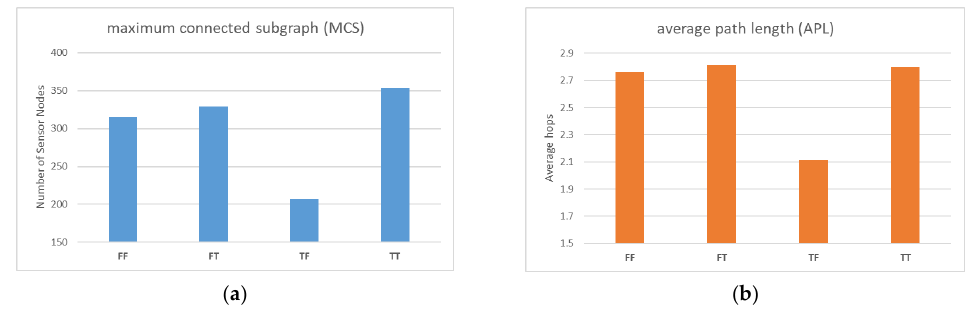
Figure 6. ( a ) Comparison of MCS with different parameter settings; ( b ) Comparison of APL with different parameter settings.